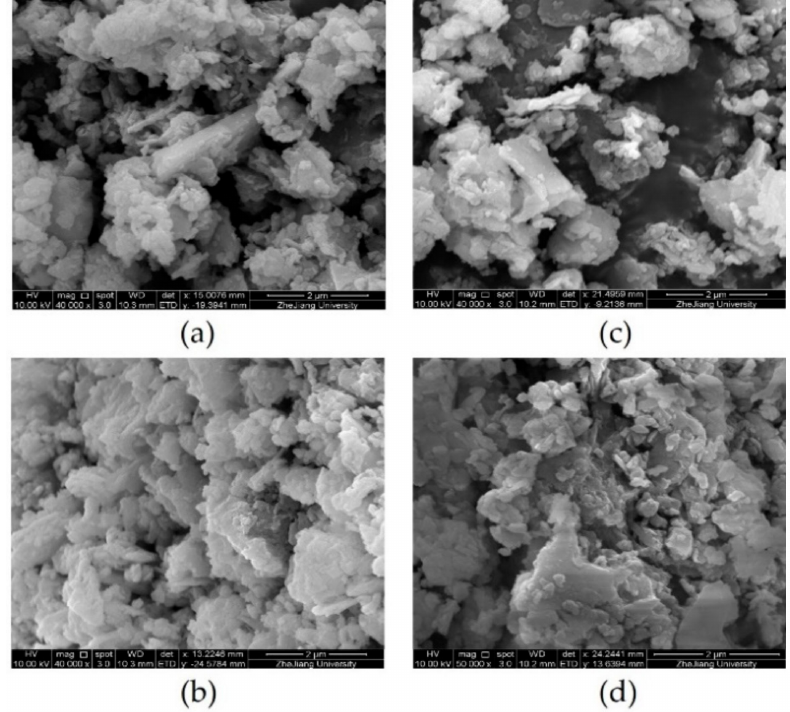
Figure 8. SEM images of flocs collected from ( a ) C / S, ( b ) PM + C / S, ( c ) Cl 2 + C / S, and ( d ) Mn(II) + C /